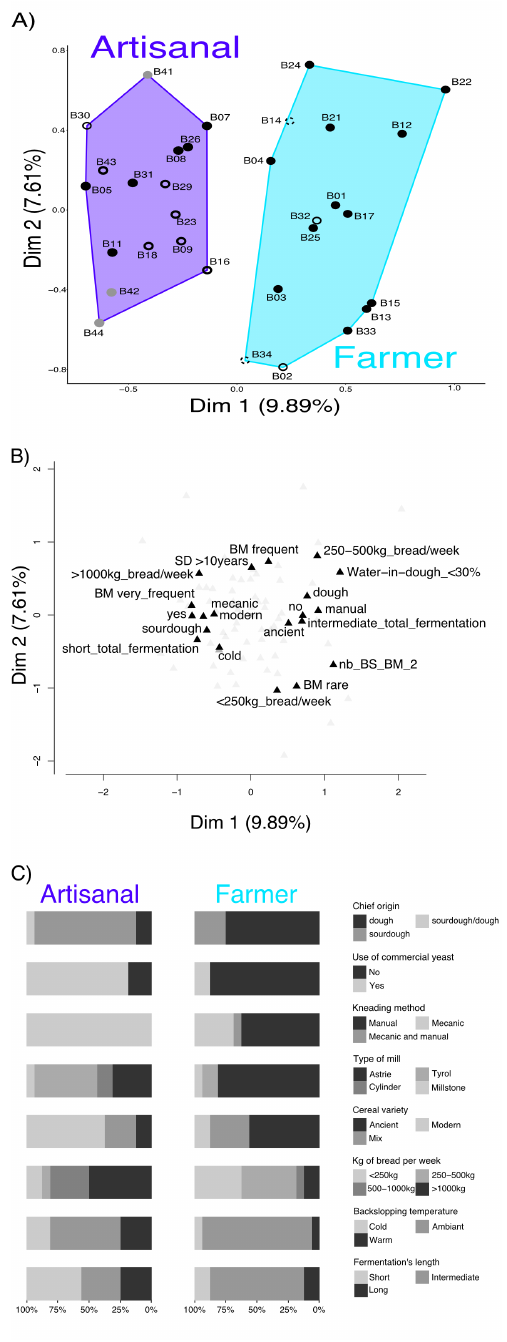
Figure 2: Multiple Correspondence Analysis (MCA) based on 28 categorical variables describing bread making practices. A) Representation of bakers. Each point represents a bakery. The purple area on the left brings together baker with “artisanal” practices and the light blue area on the right the bakers with “farmer” practices. The dot’s colors indicate the PCoA cluster of the sourdough fungal community (see Figure 5). Black dots for group 1, empty dot for group 2, grey for group 3. The fungal community of the sourdough of baker 14 was not studied. B) Representation of the 20 first categories that contributed the most to the MCA axes. The category, which corresponds to a class of a variable, is written next to